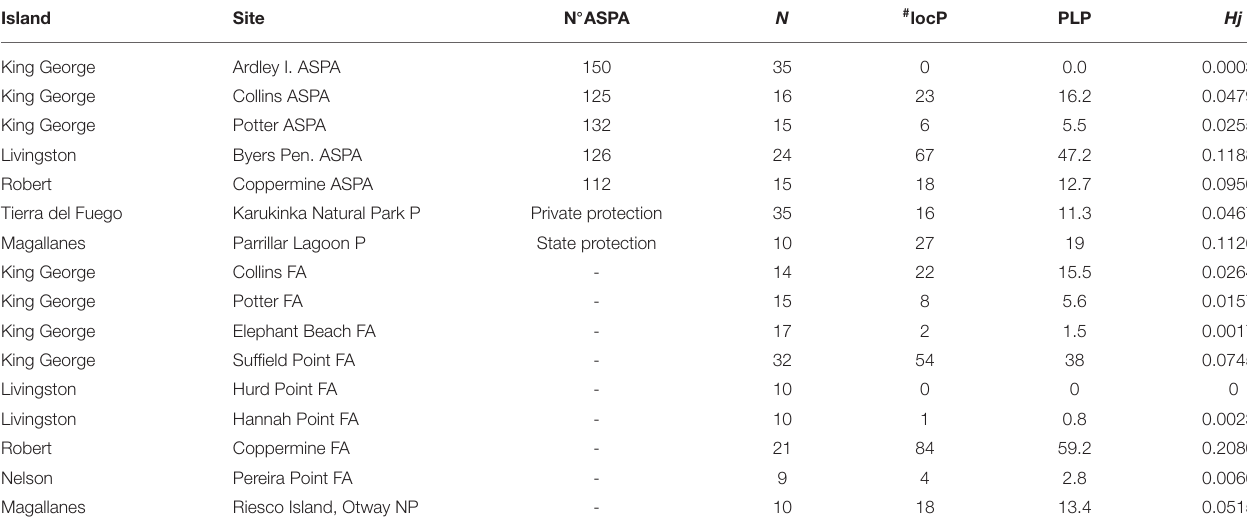
TABLE 3 | Results of genetic diversity within populations in Antarctic Specially Protected Area (ASPA) and free access sites. Island